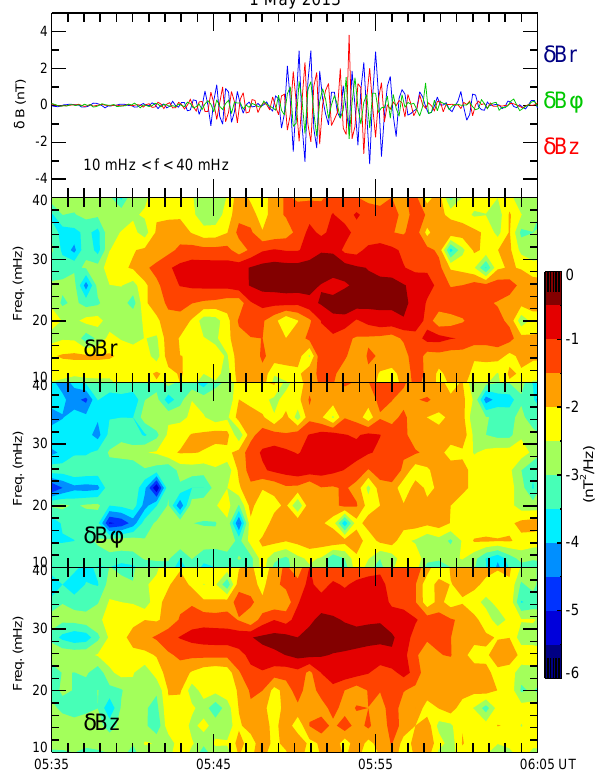
Figure 5. Magnetic field fluctuations band-pass-filtered in the 10 to 40mHz frequency range in field-aligned coordinates from 05:35 to 06:05UT. The upper panel presents radial ( δBr ), azimuthal ( δBϕ ), and field-aligned ( δBz ) components of magnetic field fluctuation. The second, third, and fourth panels show their corresponding power dynamic spectra.